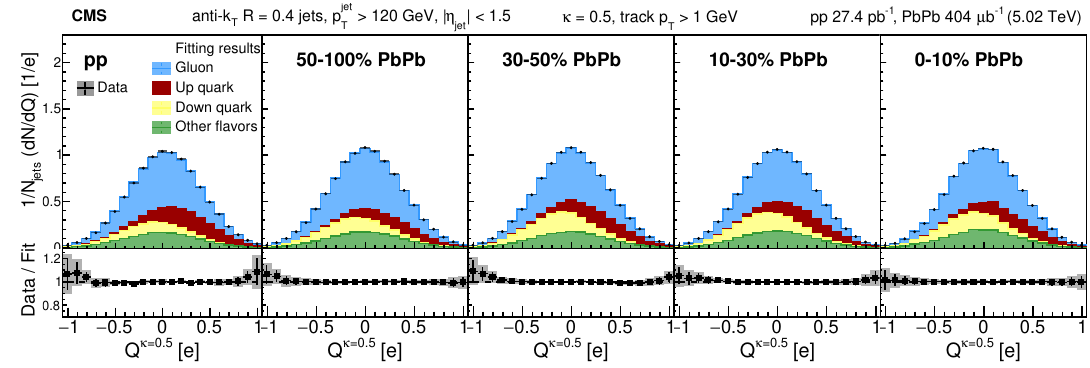
Figure 1 . (Upper) Unfolded jet charge measurements shown for inclusive jets in data along with the extracted fractions of up, and down quark jets, gluon jets, and the \other (cid:13)avor" jets. The systematic and statistical uncertainties in the distributions are shown by the shaded regions and vertical bars, respectively. The jet charge measurements shown here are for the p -weighting factor T (cid:20) = 0 : 5 and a minimum track p of 1 GeV. (Lower) Ratio of the jet charge measurements to the T results of template